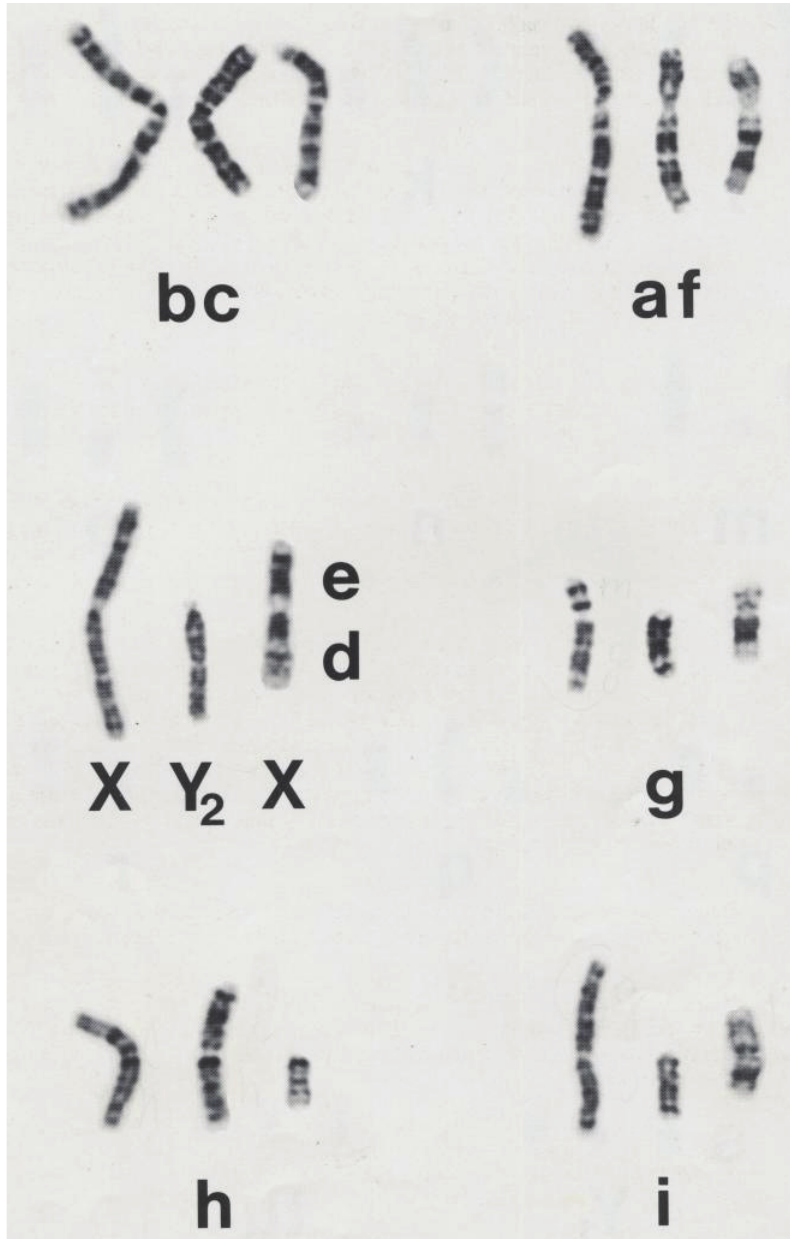
Fig. 1. Chromosome arms a - i (also, v , the short arm of Y lows (given left to right): g: gm, gm; h: hj, hi; i: gi, hi